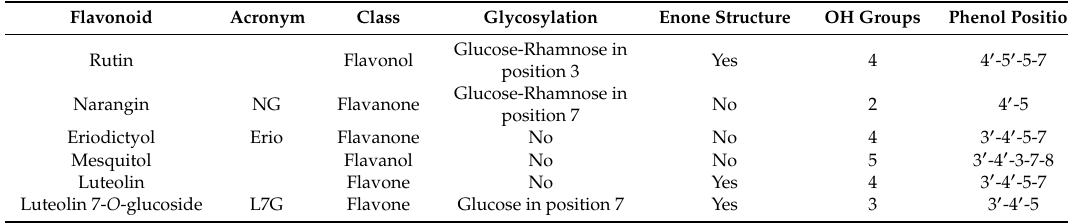
Table 3. Structural features of the flavonoids